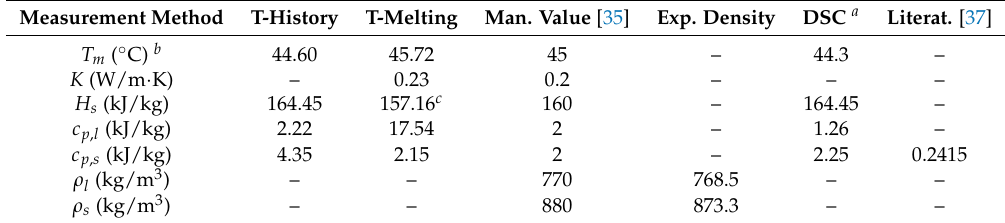
Table 8. Comparison of the thermal properties measured of RT45, a Rate 0.5 K/min, b Cooling, c H m